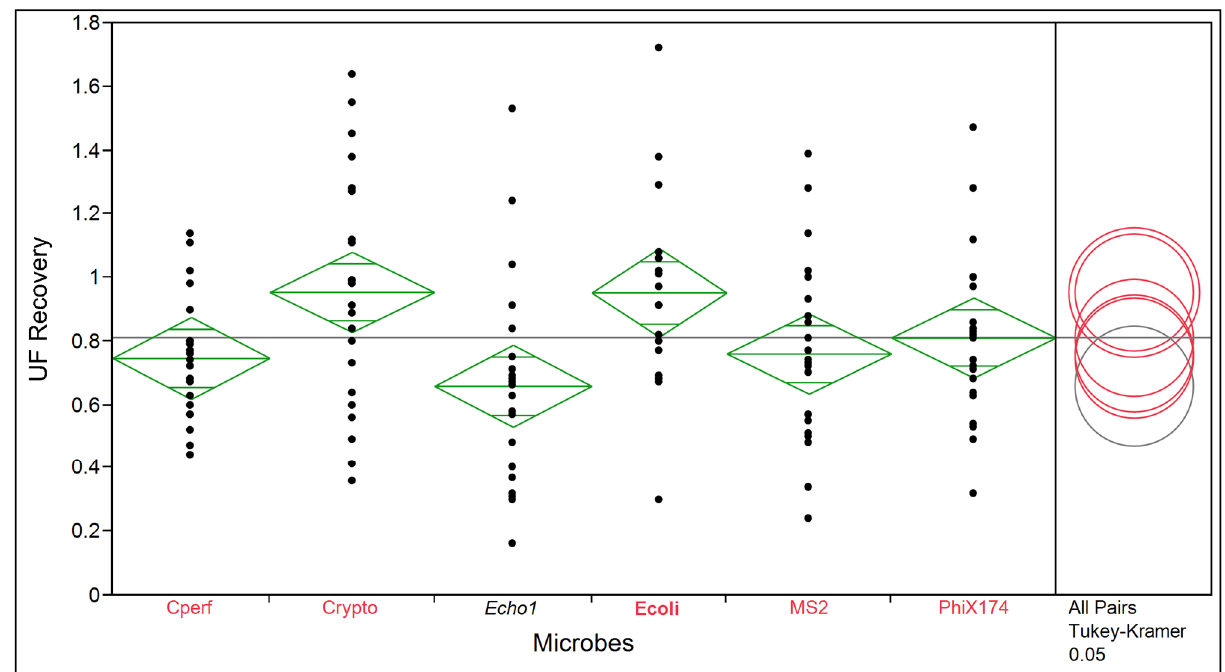
Figure 1. One-way ANOVA for UF percent recovery. Diamonds represent means (line near the center of each diamond), with 95% confidence intervals for each mean (the vertical span), based on the pooled estimate of the standard error. Comparison circles summarize the results of the multiple comparison procedure. The selected mean has bold, red circle and variable label (in this Figure, E. coli ). Means that are not significantly different from the selected mean have unbolded, red circles and variable labels. Means that are significantly different from the selected mean have gray circles and gray italicized variable labels. In this example, the mean for E. coli is significantly different from the mean for echovirus 1, but is not significantly different from the mean for other